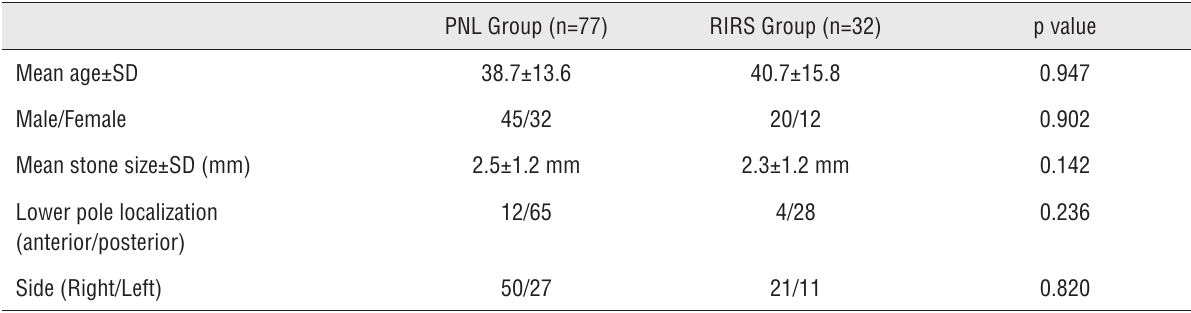
Table 1 - Stone Characteristics and Demographic Data of